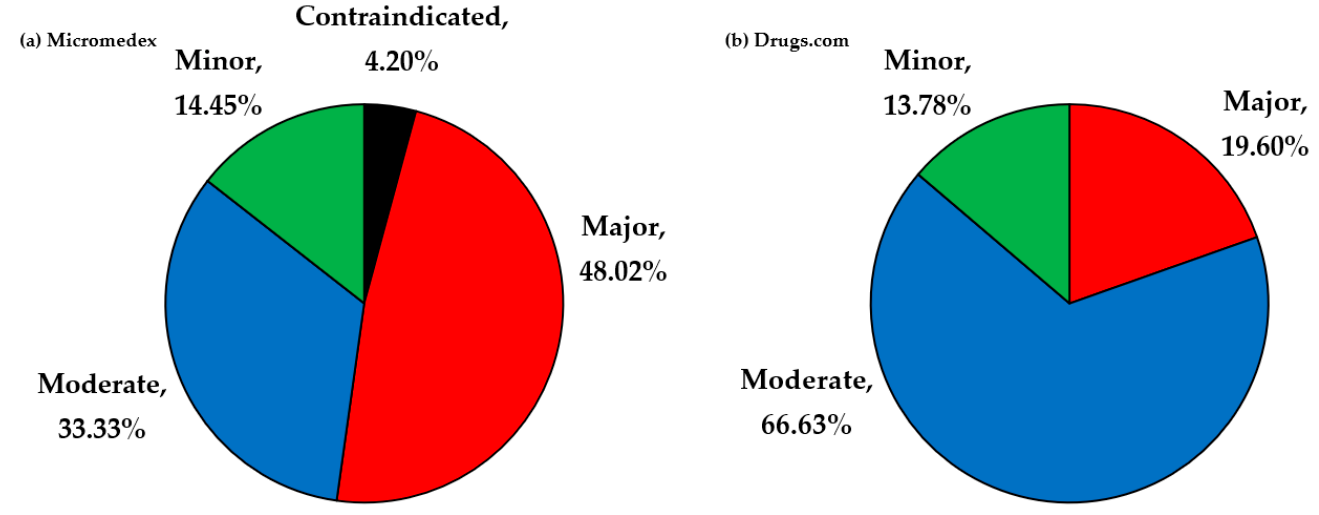
Figure 2. Collation result of the potential DDIs between the two databases: ( a ) Micromedex; ( b ) Drugs.com.